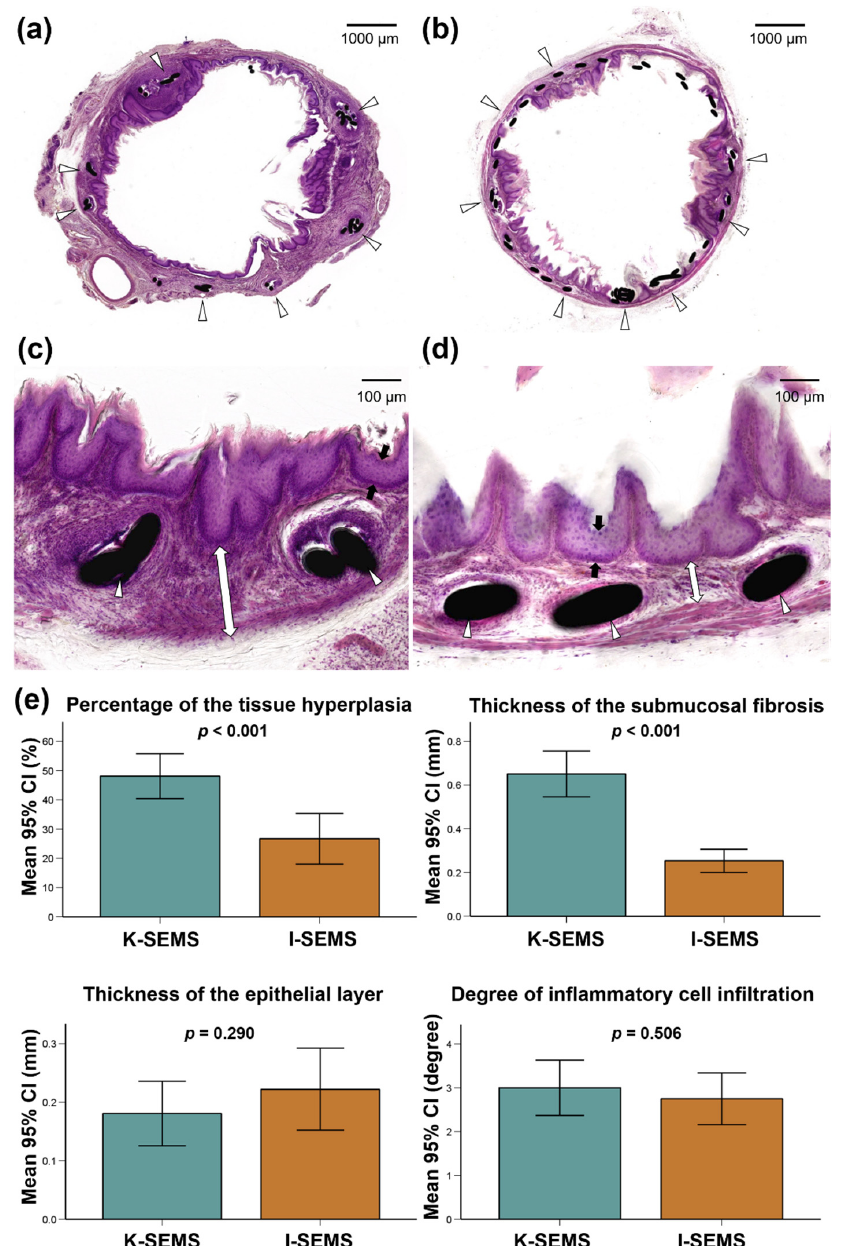
Figure 4. Representative microscopic images of the histologic sections. Formation of stent-induced tissue hyperplasia through the wire filaments (arrowheads) was evident in both the K-SEMS and I-SEMS groups. The degree of stent-induced tissue hyperplasia in ( a ) the K-SEMS group was significantly higher than that in ( b ) the I-SEMS group. ( c , d ) The submucosal fibrosis (arrow) in the K-SEMS group was significantly thicker than that in the I-SEMS group. The thickness of the epithelial layer (black arrows) was not significantly different between the two groups. ( e ) Histologic results of the stented rat esophagus at 4 weeks after stent placement in the K-SEMS and I-SEMS groups. K-SEMS, knitted self-expandable metallic stent; I-SEMS, interwoven self-expandable metallic stent; CI, confidence